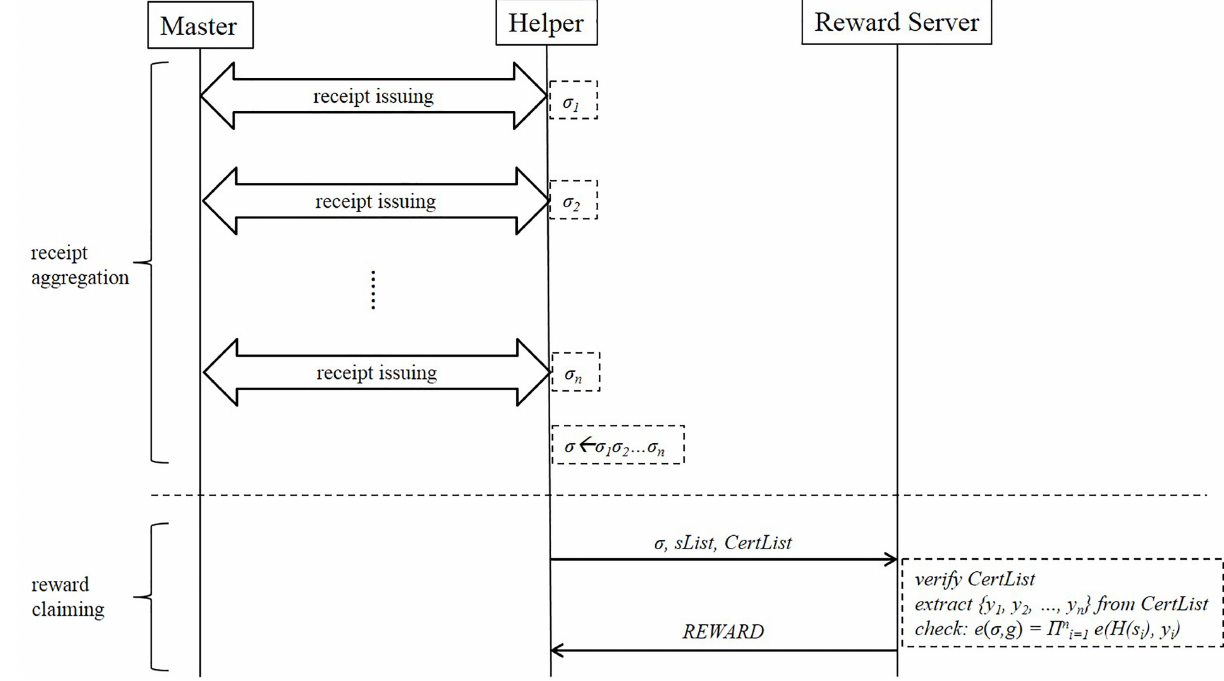
Figure 3. Protocol of reward scheme with